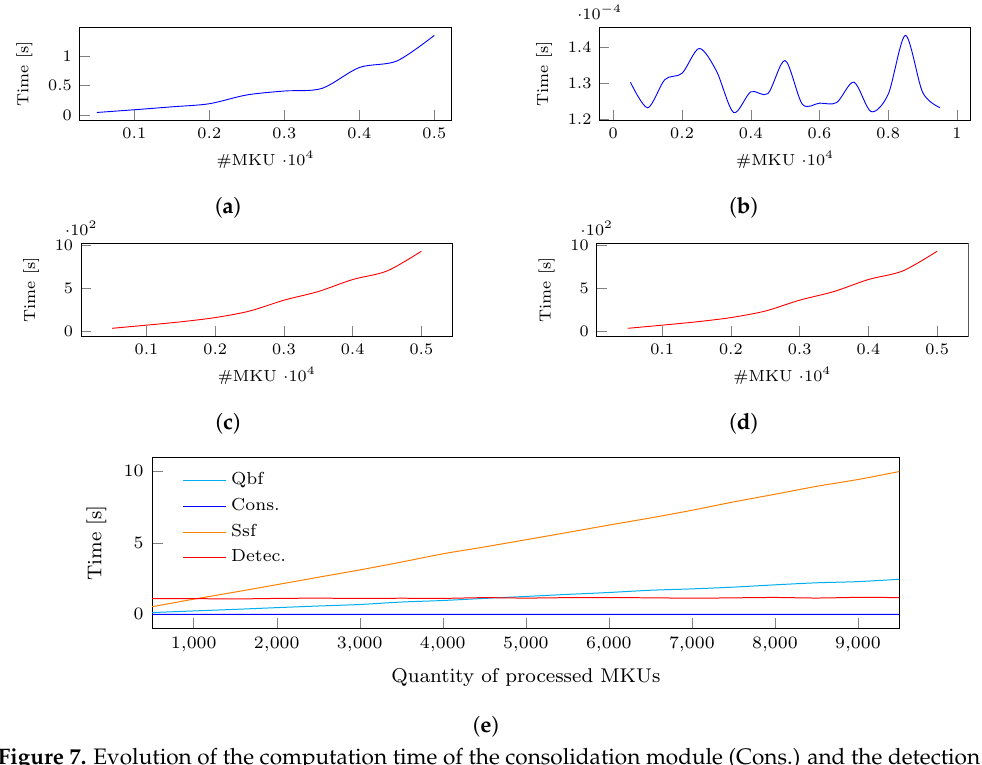
Figure 7. Evolution of the computation time of the consolidation module (Cons.) and the detection module (Detec.), without ( ) and with ( ) the query based filtering ( Qbf ) and the search space ¬ ∧ filtering ( Ssf ) enabled, for every processed query of 500 MKUs. ( a ) Cons. filtering. ( c ) Detec. filtering. ( d ) Detec. filtering. ( e ) Evolution of the computation time of each ¬ ∧ module in